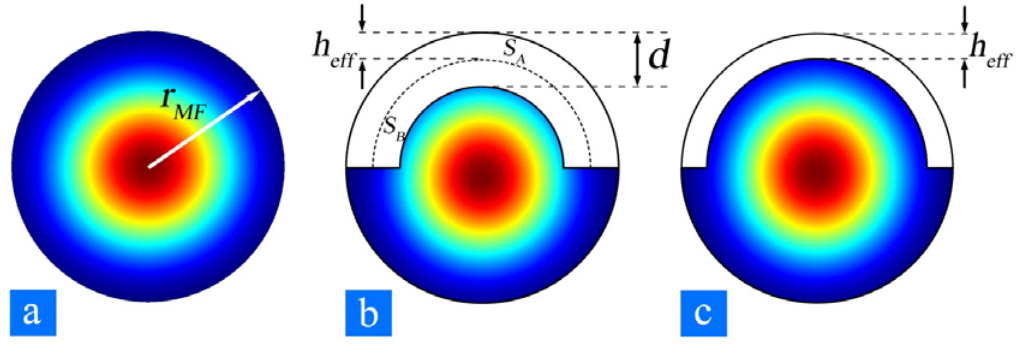
Figure 4. The cross-section and fundamental modal field distribution of ( a ) an un-milled MF, ( b ) a milled MF and ( c ) an equivalent unperturbed geometry, respectively. d is the depth of the corrugation and h is the boundary shift. S (S ) is the area bounded by the eff A B upper(lower) part of the corrugation. Modal fields are calculated for r = 2 μ m, MF d = 200 nm, and h = 97.4 eff